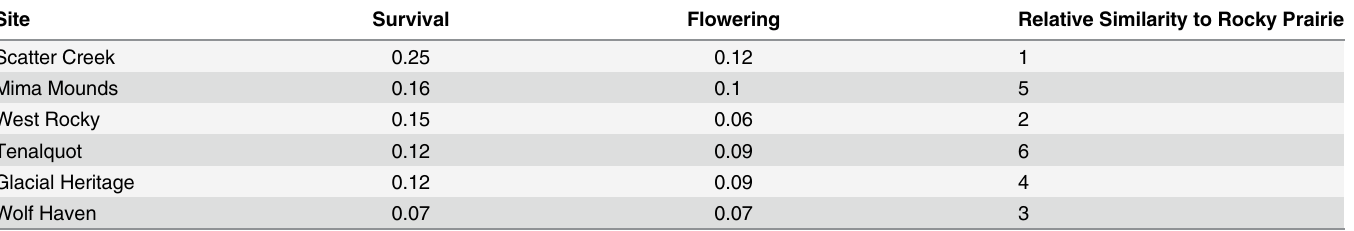
Table 1. Survival and Flowering of Outplanted Golden Paintbrush Plugs After Five Years, and Relative Similarity of Sites to Rocky Prairie as Deter- mined by Caplow and Chappell[9].